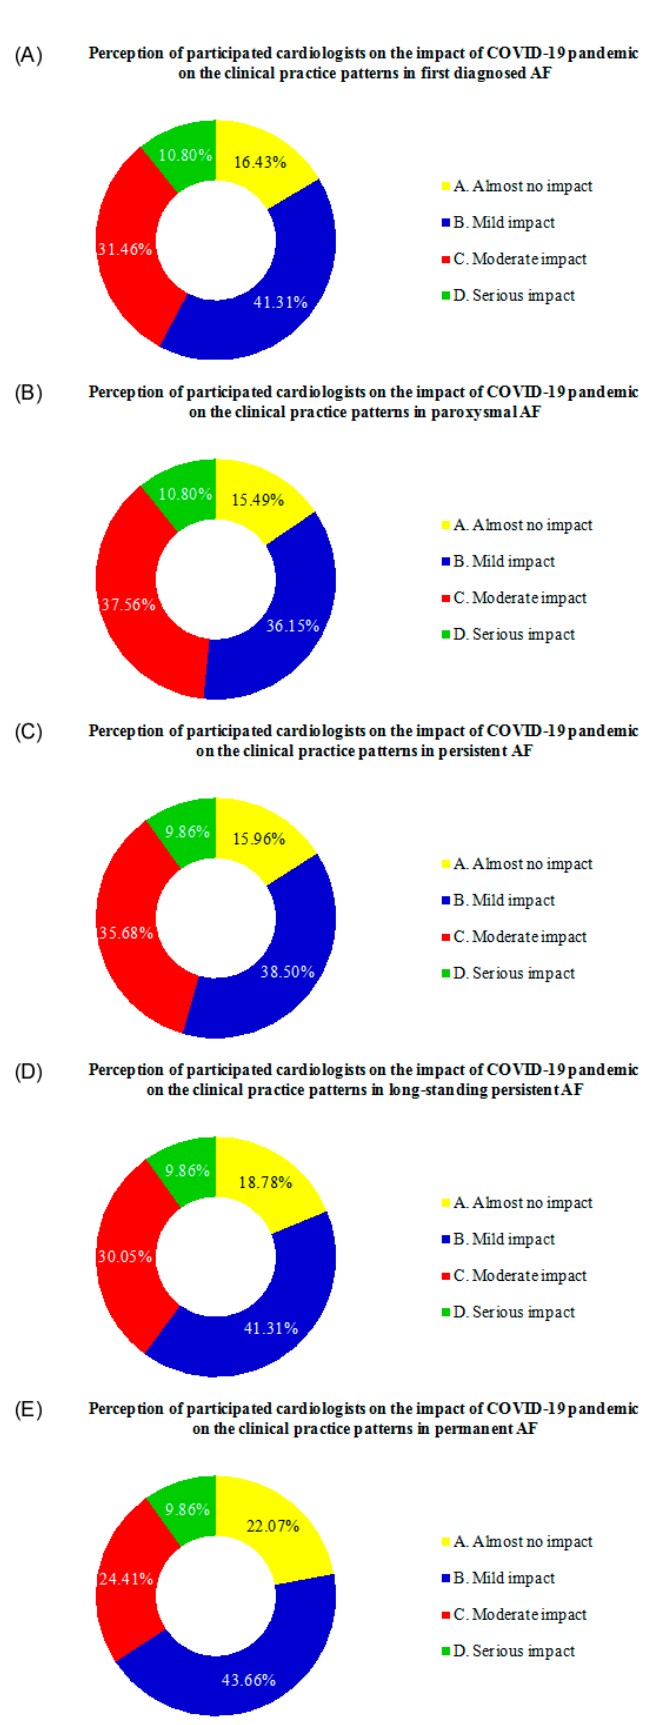
Figure 2. Cardiologists’ perceptions of how the COVID-19 pandemic affected AF clinical practice